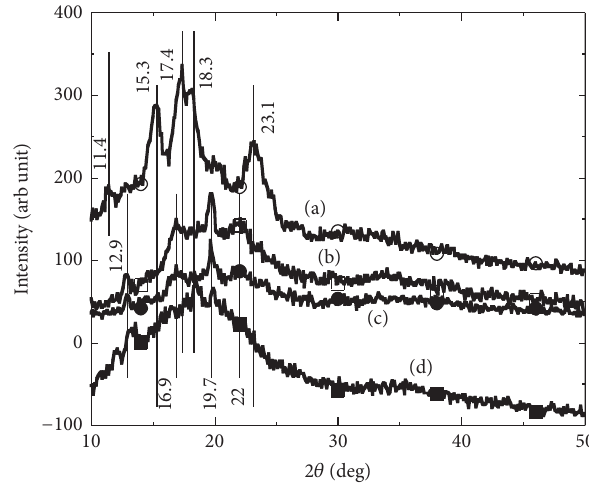
Figure 3: The XRD pattern of pure starch (a), sample P1 (b), sample P2 (c), and sample P3 (d) before